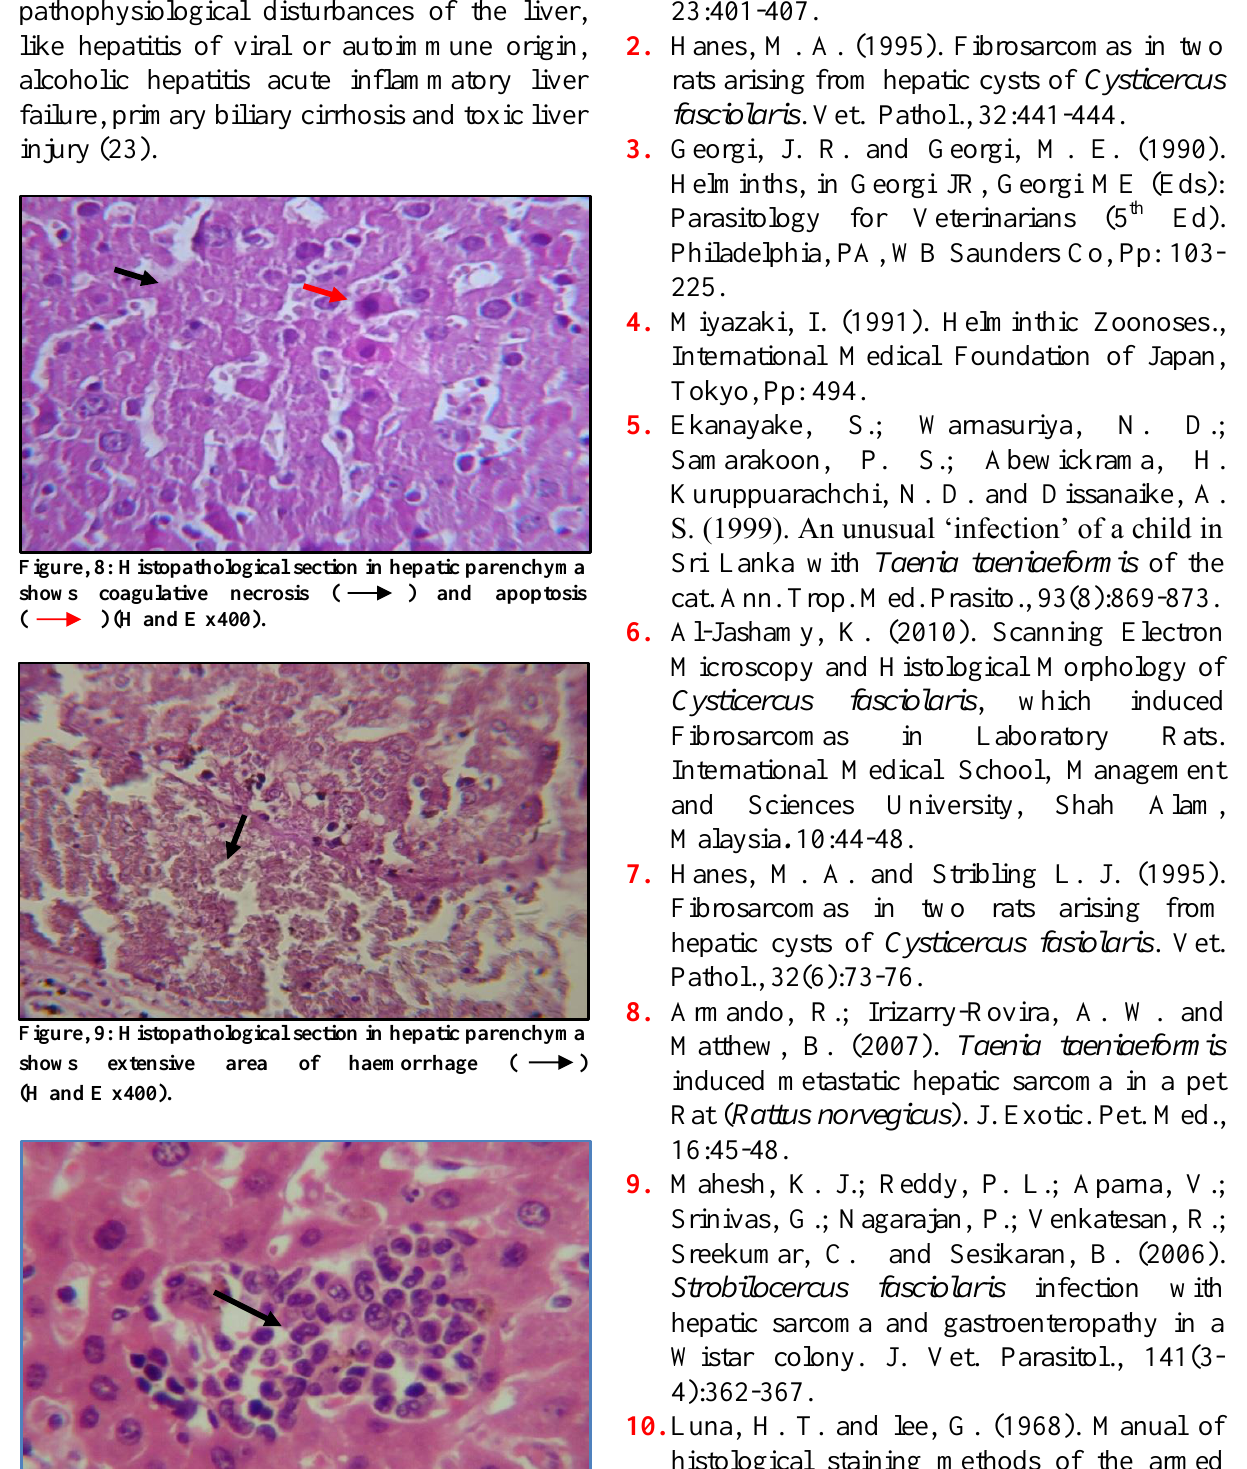
Figure, 10: Histopathological section in hepatic parenchyma shows formations of early granulomas ( ) (H and E